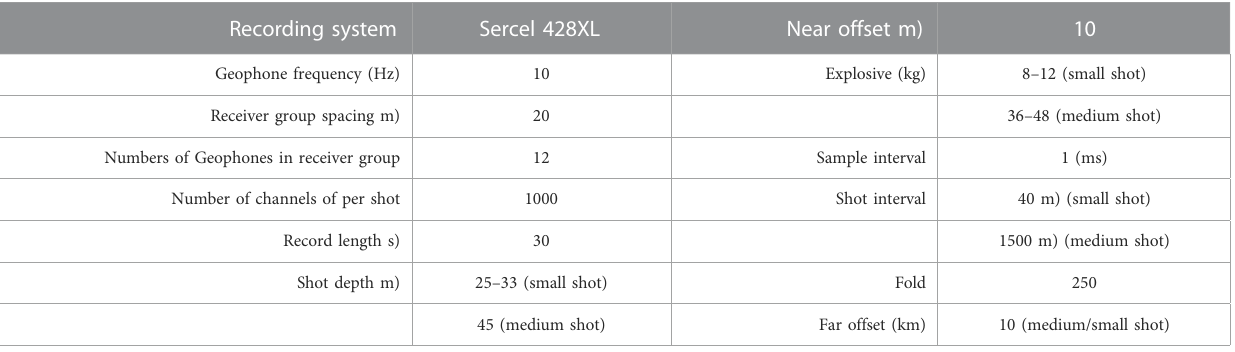
TABLE 1 Seismic data acquisition parameters along the pro fi